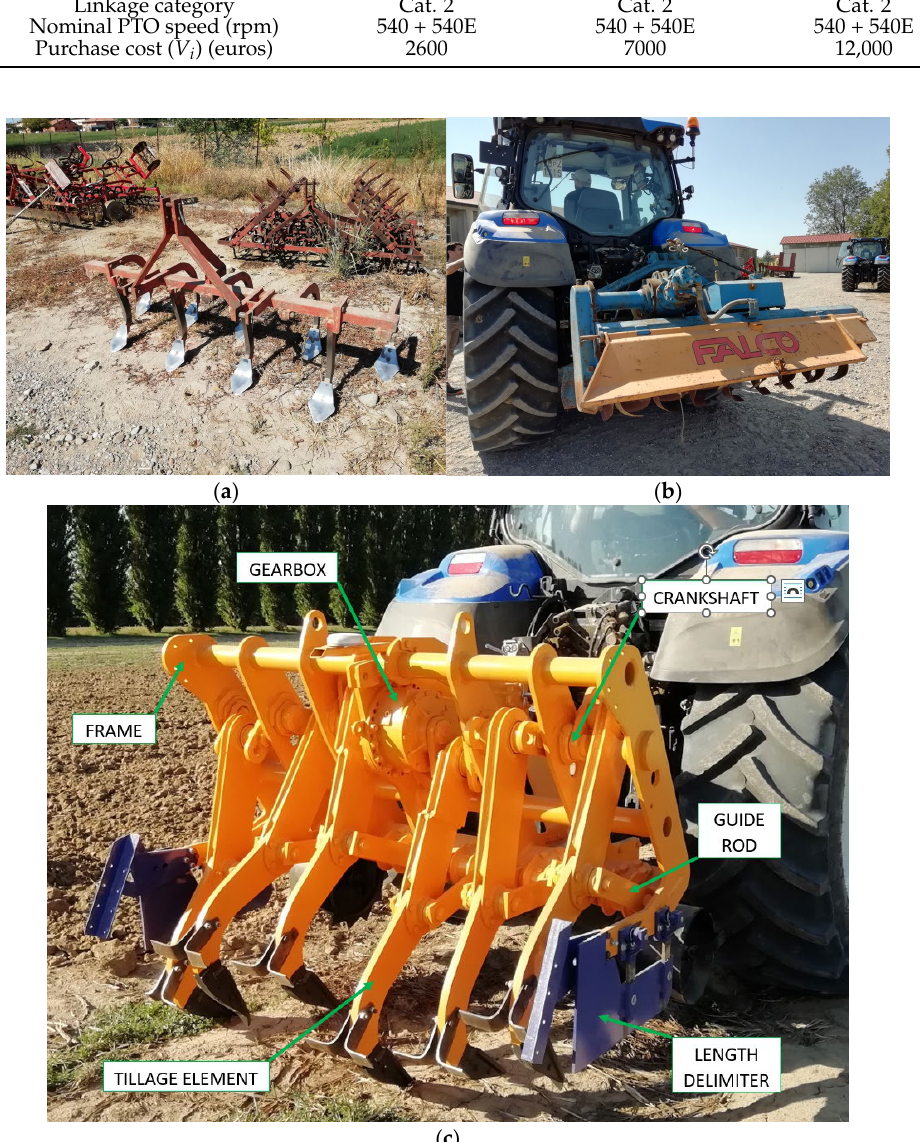
Figure 1. Pictures of the conventional tillage implements ripper ( a ) and rotary tiller ( b ) used for the tests. Pictures highlighting the main components of the Rotoripper ( c ), a ripper with a crankshaft actuated by the tractor PTO that permits the rotation of its working elements as on a standard rotary